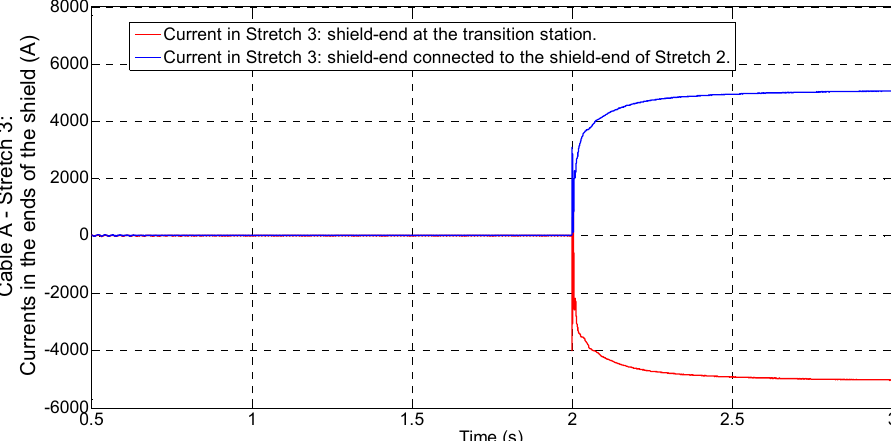
Figure 11. Circulation of ground fault currents in the ends of the shield in Stretch 3 of Cable A in case of external ground fault in Cable A, Stretch 1.